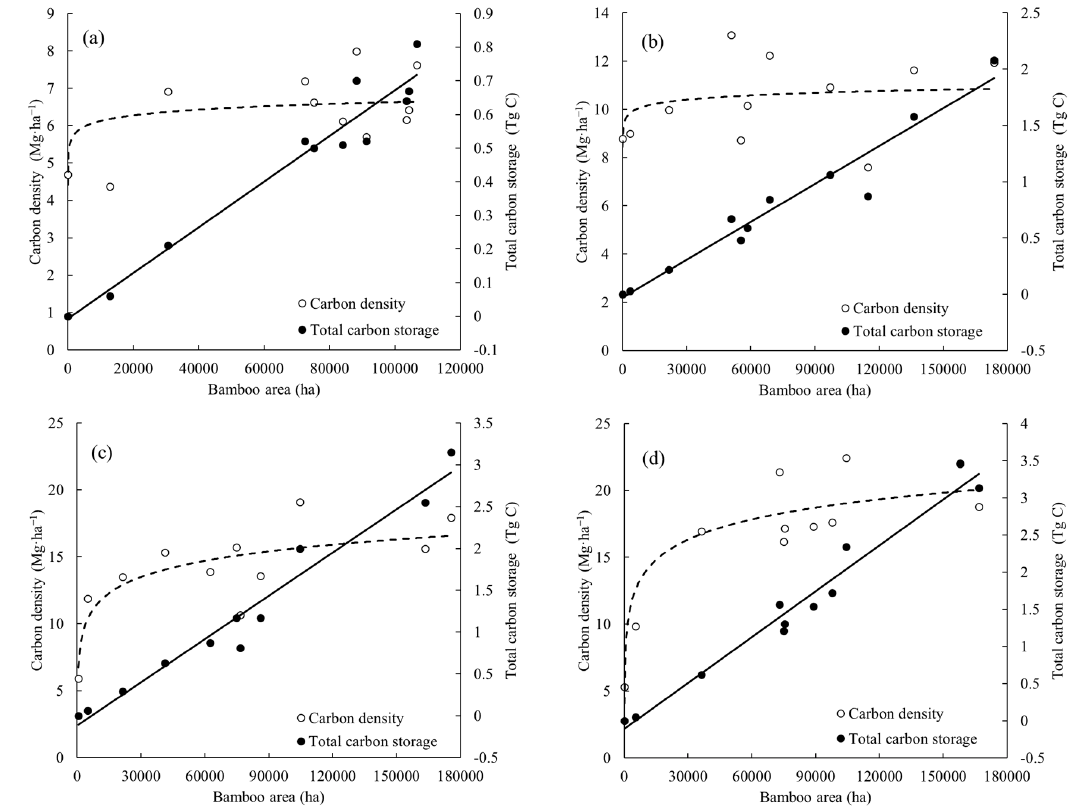
Figure 10. Relationship between bamboo forest area and carbon density, total carbon storage in different years. ( a – d ) represents the year of 2000, 2004, 2008 and 2014, respectively.